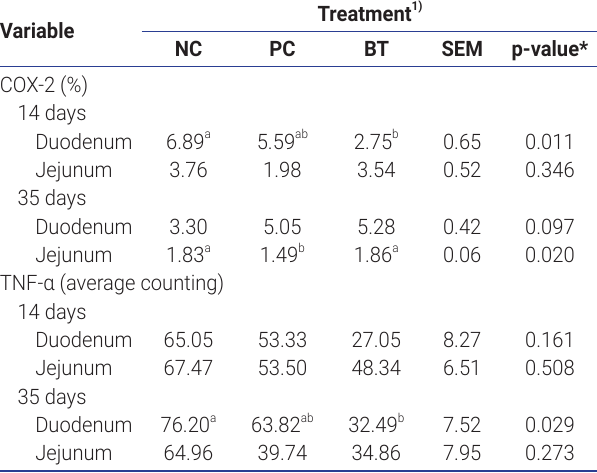
Table 4. Immunohistochemistry in the duodenum and jejunum of piglets at 14 days and 35 days of experiment